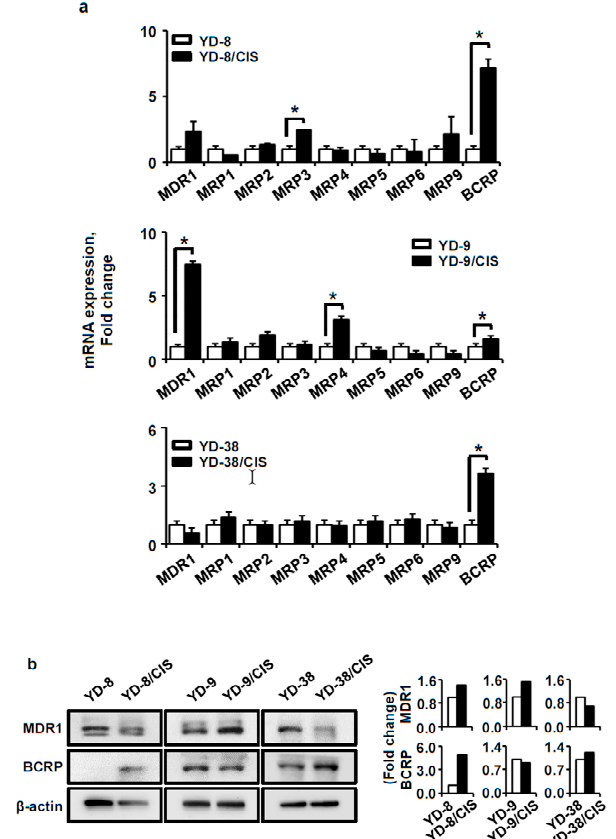
Figure 2. Di ff erences in expression of multi-drug resistant (MDR)-related genes and proteins in parental and cisplatin-resistant OSCC cell lines. ( a ) The expression of MDR-related genes was measured by qPCR (mean ± SD; n = 3). * p < 0.01 versus parental cells. ( b ) Left, the expression of MDR1 and BCRP proteins was determined by a Western blot assay. Right, data represent quantitative results for left panel. Exposure to cisplatin induces upregulation of BCRP in YD-8 and YD-38 cells, and upregulation of MDR1 in YD-8 and YD-9